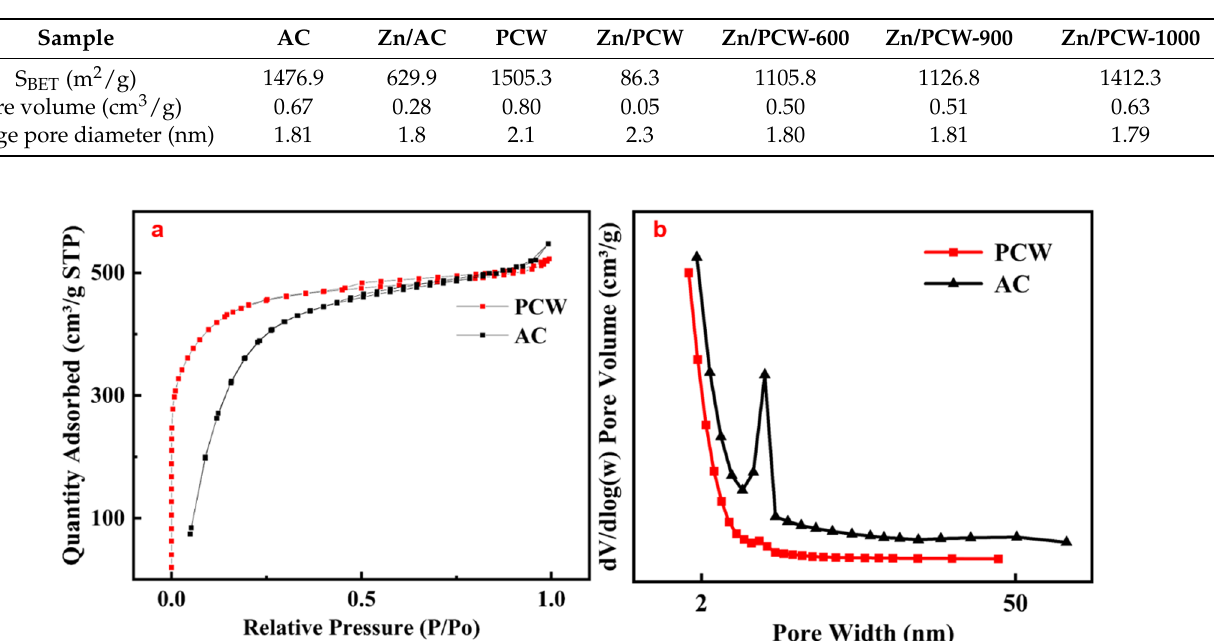
Figure 2. ( a ) Nitrogen (N 2 ) adsorption and desorption isotherms and ( b ) pore size distributions of AC and